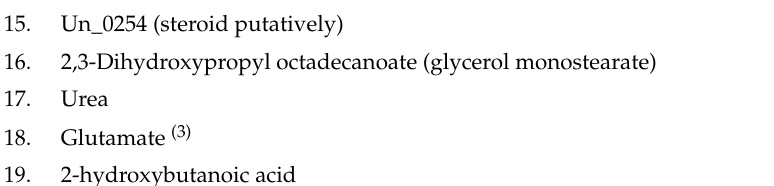
Table 3. Cont. Negatively Significant Metabolites in the S vs. the R Group in Decreasing Significance